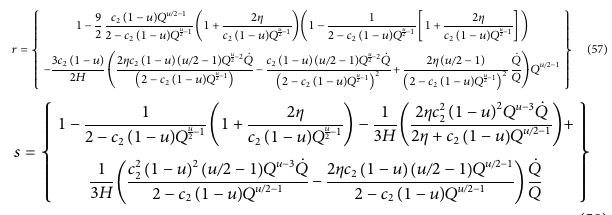
Figure 14 , shows the evolution trajectory for pilgrim dark energy f ( Q ) gravity model in ( r − s )- plane towards different value of η . From Figure 14 , the evolution trajectories of ( r − s )- plane favor the quintessence fi eld dark energy model with s > 0 and r < 1.